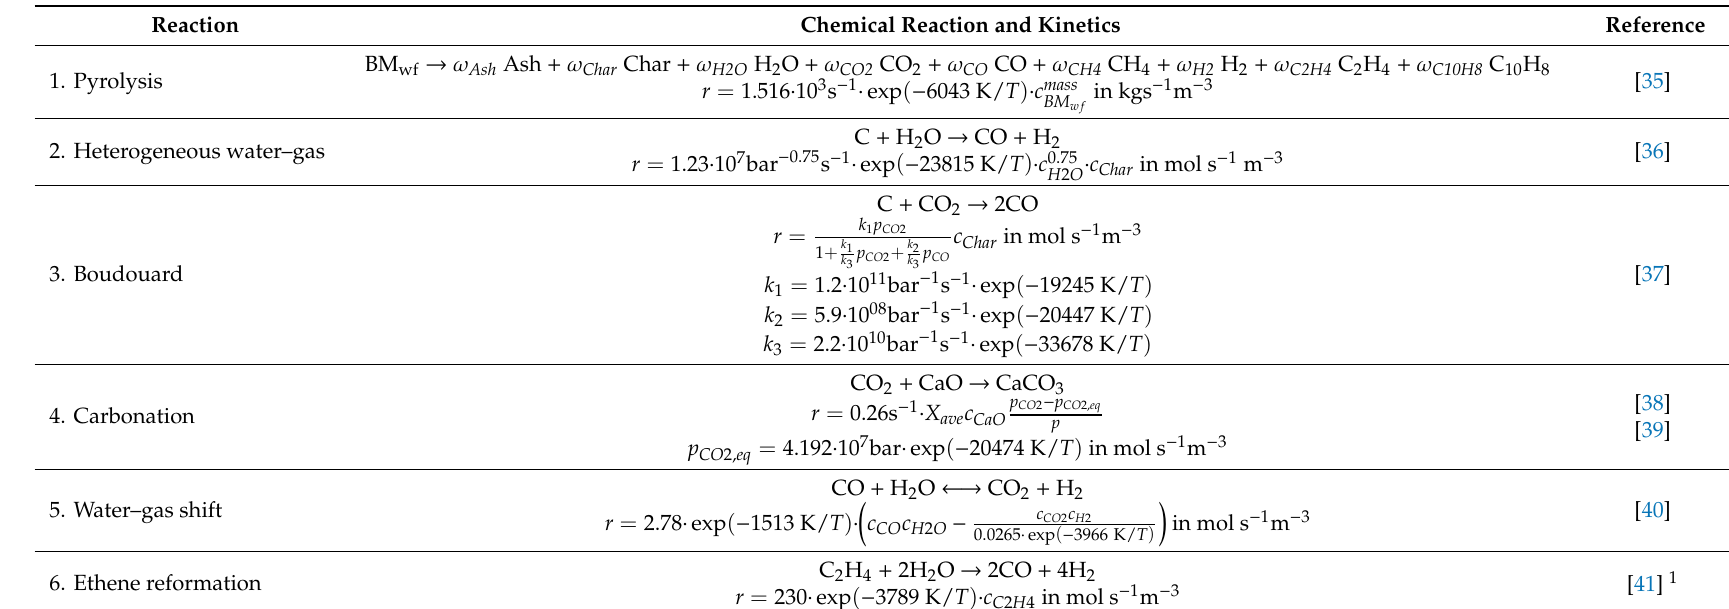
Table 1. List of chemical reactions and reaction